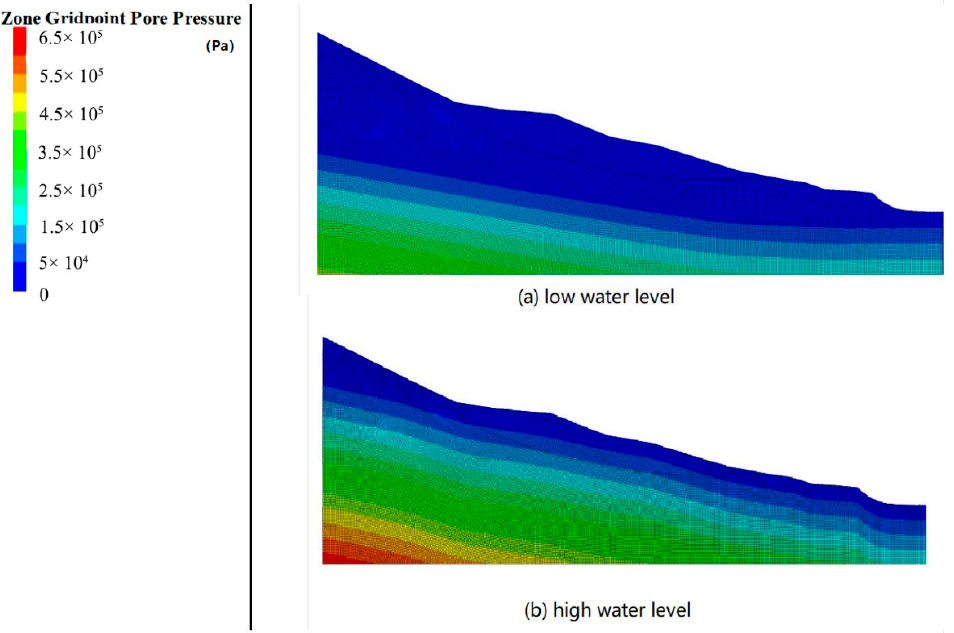
Figure 21. The numerical model of the profile.